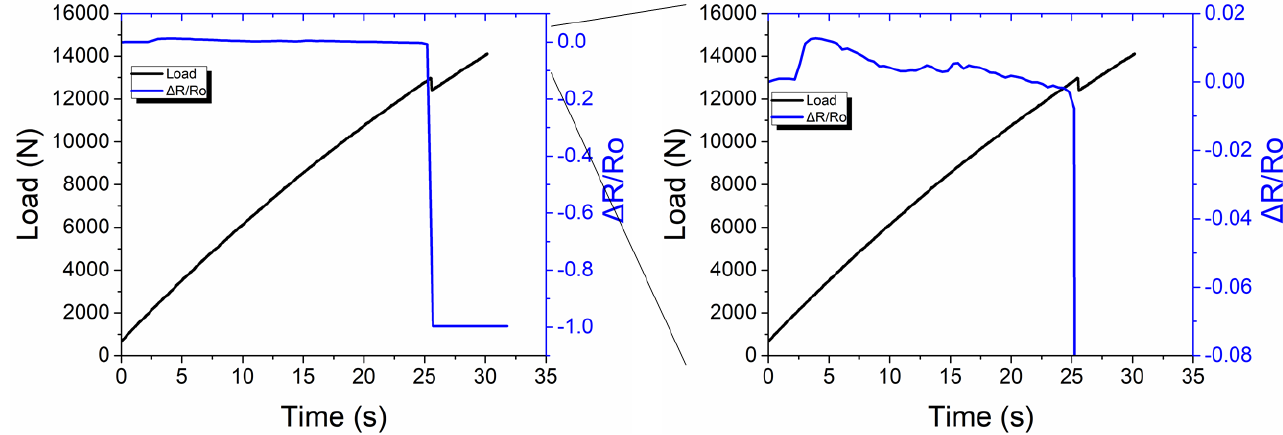
Figure 26. Representative lap strap test of RTM6 composite and ERCM monitoring ( left ) and zoom in the resistance before failure ( right ).